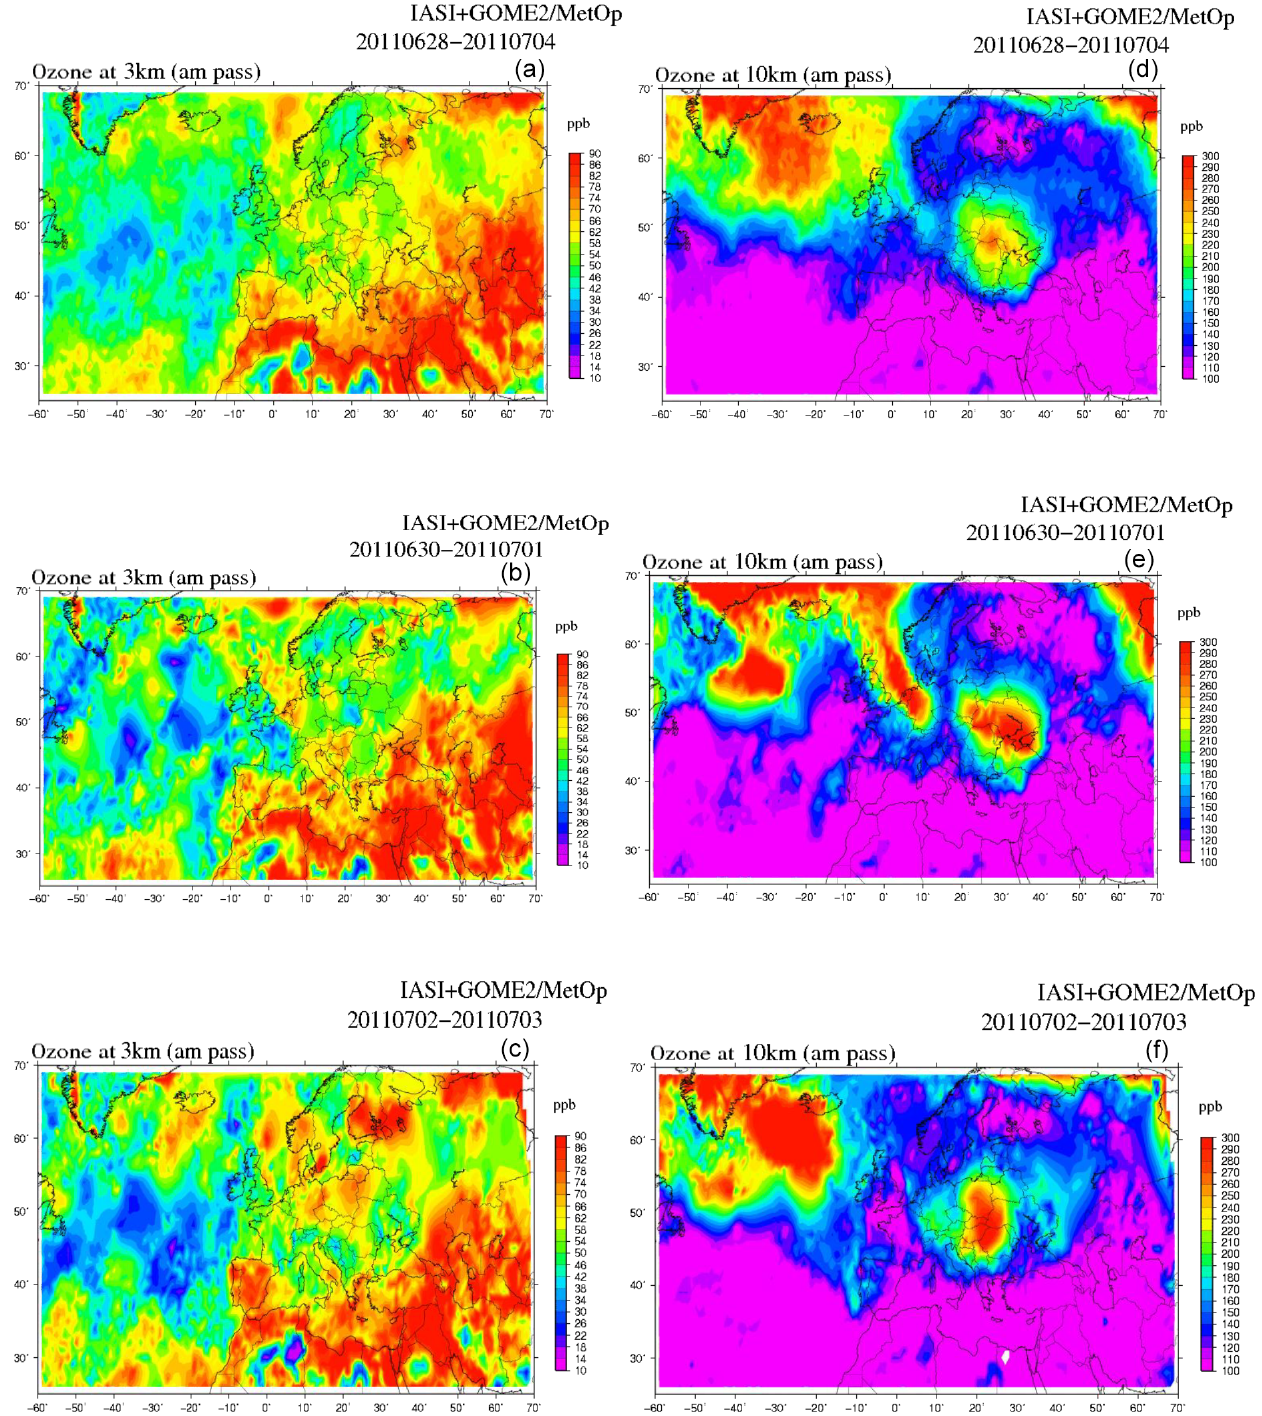
Figure 11. IASI + GOME-2 satellite images of ozone concentration at 3km (a, b, c) and 10km (d, e, f) for the episode of 28